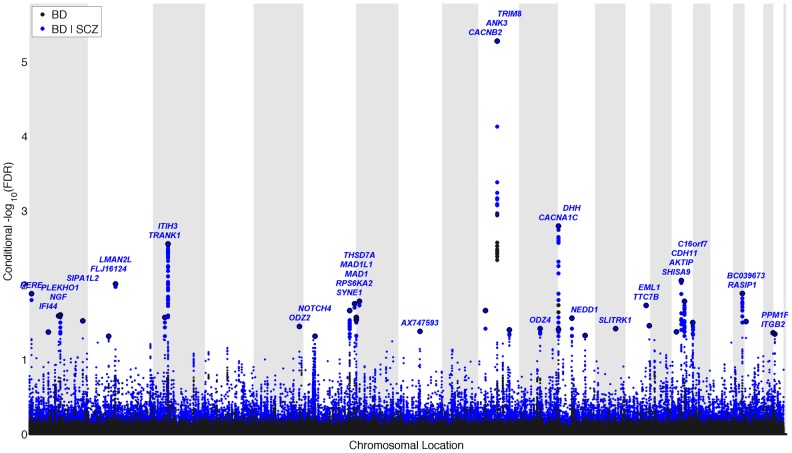
“Conditional Manhattan plot” of conditional −log10 (FDR) values for Bipolar disorder (BD) alone (black) and BD given schizophrenia (SCZ; BD|SCZ, blue).SNPs with conditional −log10 FDR>1.3 (i.e. FDR<0.05) are shown with large points. A black line around the large points indicates the most significant SNP in each LD block and this SNP was annotated with the closest gene, which is listed above the symbols in each locus. The figure shows the localization of significant loci. Details about the loci are provided in Table 2.